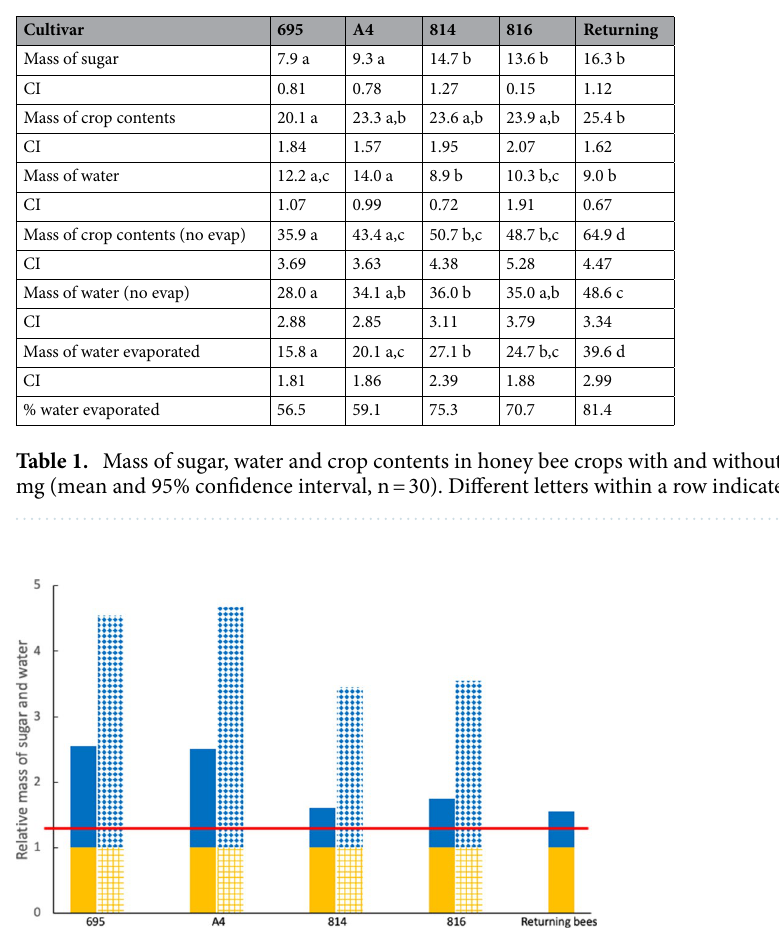
Figure 2. Relative masses of sugar and water in crop contents of honey bees. Masses of sugar (yellow) and water (blue) are shown for bees foraging on four Macadamia cultivars, compared with the estimated values if no evaporation occurred. Estimated values (not solid) are based on crop contents remaining at the same concentration as nectar. Foragers returning to the hive are also included. The red horizontal line indicates the composition of honey (80% w/w